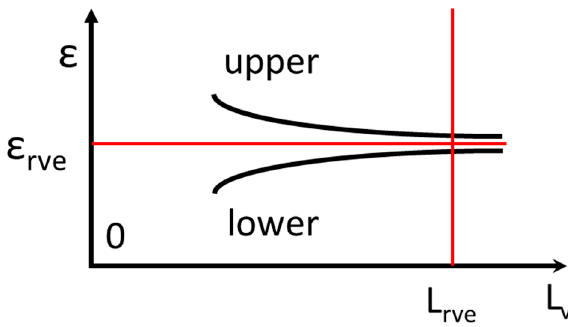
Figure 1. Variation of local strain value with respect to the representative volume element scale.